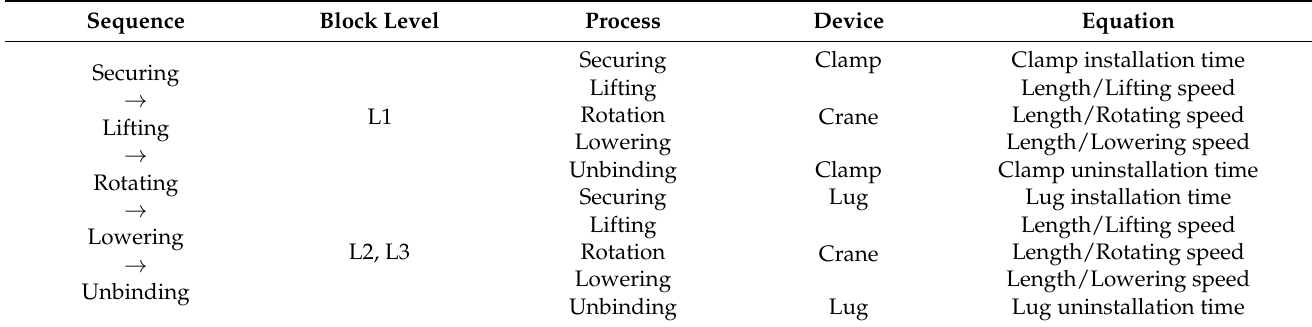
Table 3. Detailed procedure of turnover